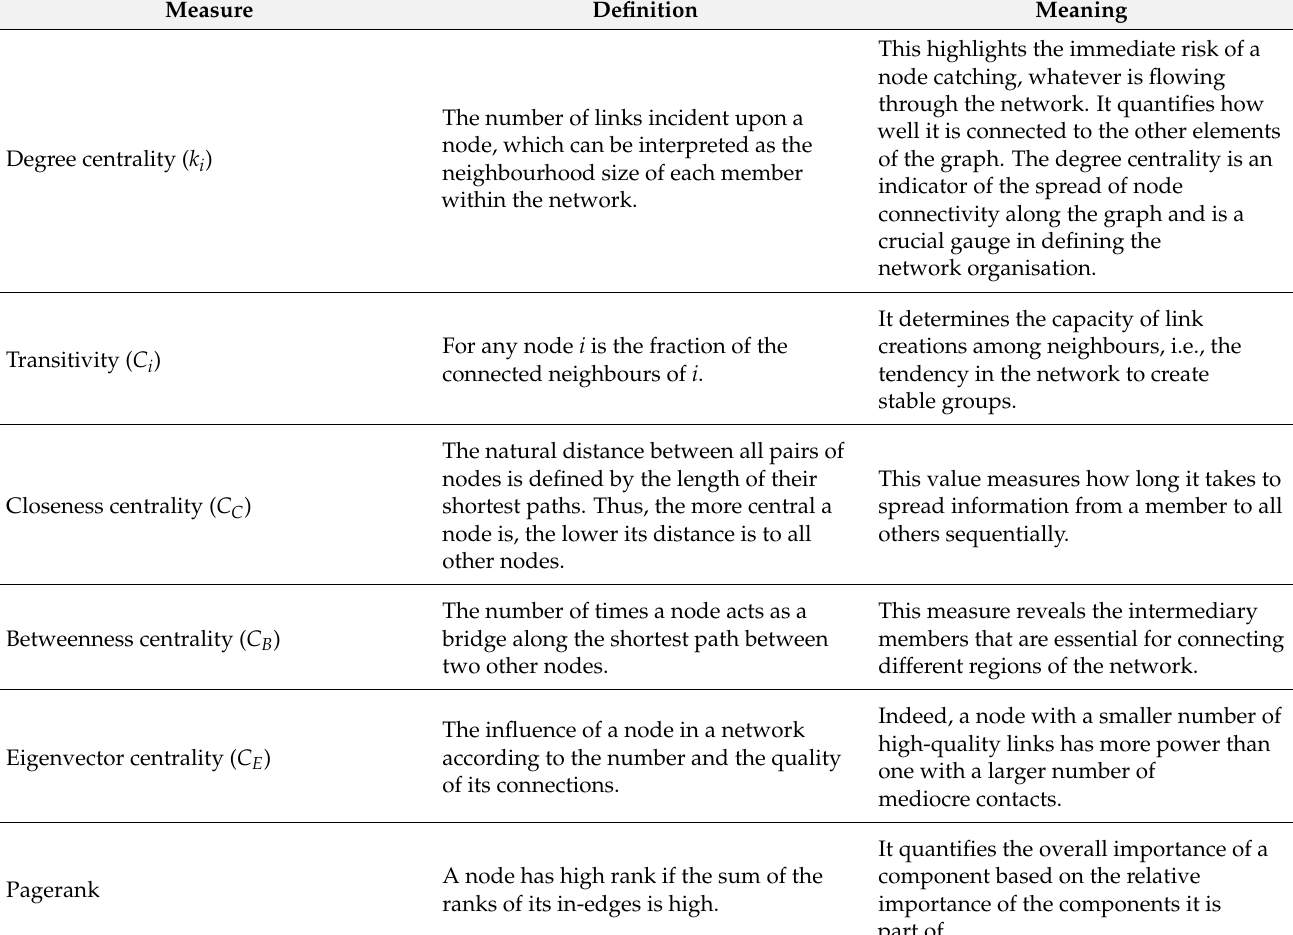
Table A1. A short glossary of centrality